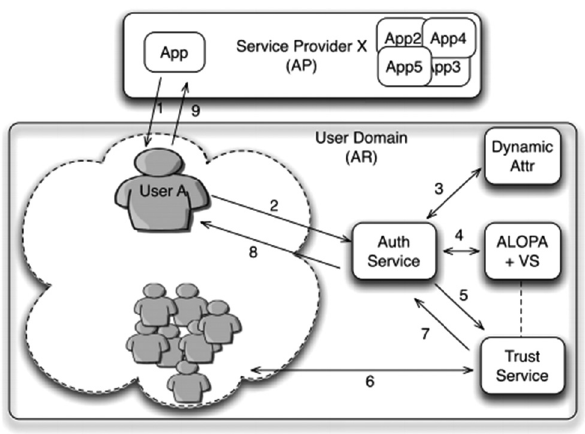
Figure 2: Example